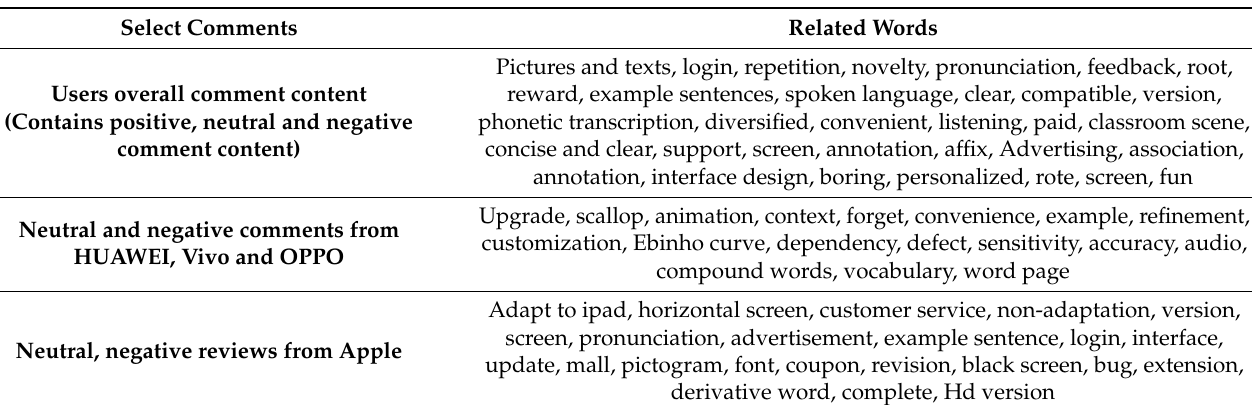
Table 3. BaiCiZhan comments on content hot high-frequency keywords.